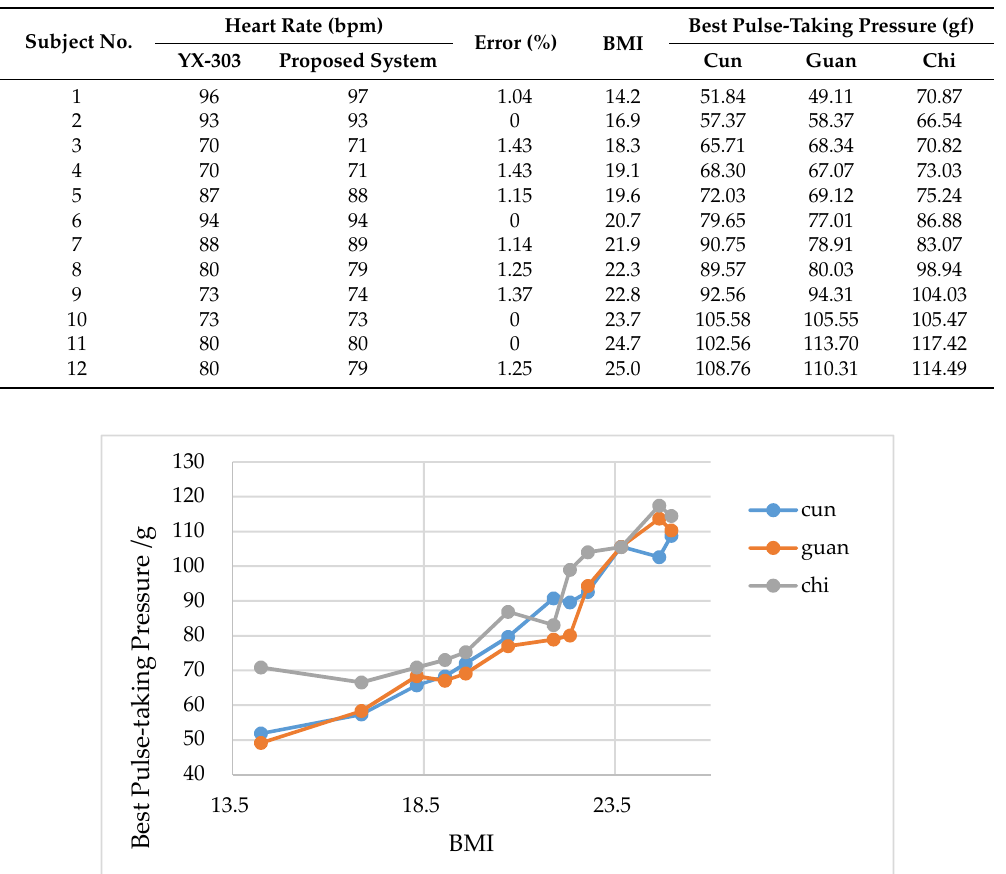
Table 1. Experiment results.